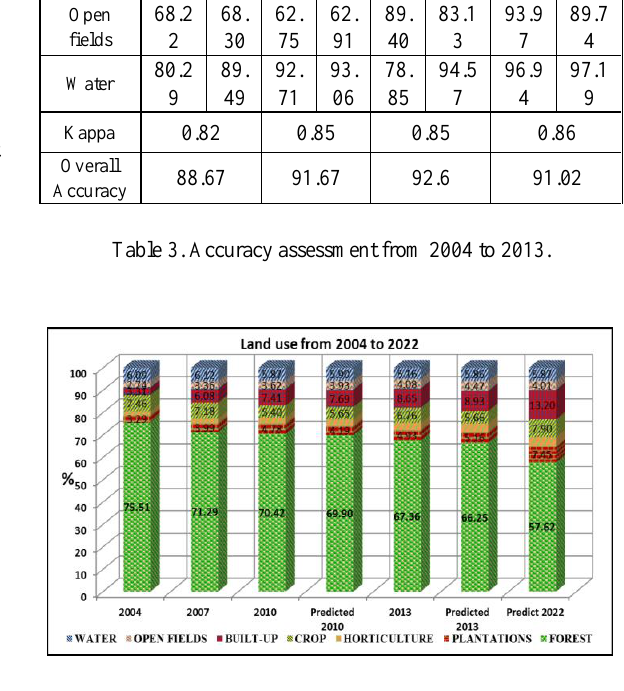
Figure 3. Land use analysis of Karwar taluk actual and predicted.